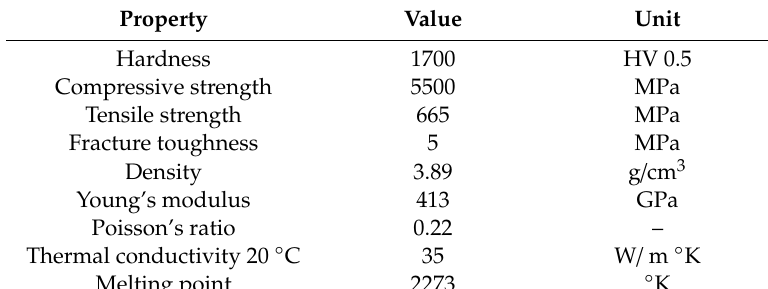
Table 1. Mechanical and thermal characteristics of Al 2 O 3 [38]